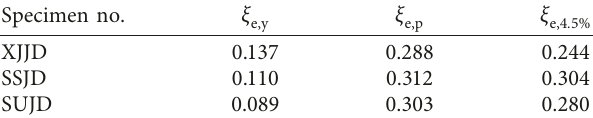
Table 12: Equivalent damping ratio. Specimen no.